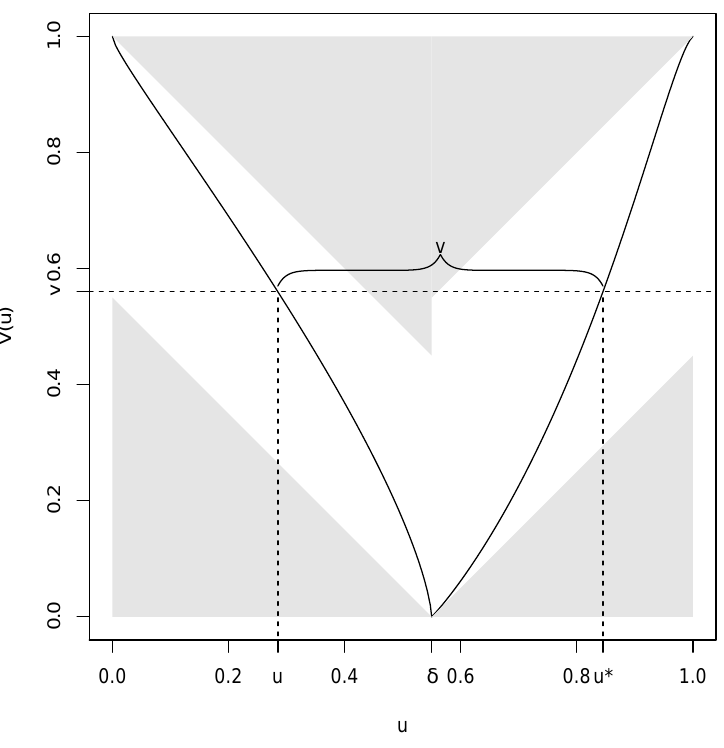
Figure 3. An asymmetric v-transform from the family defined in (7). For any v-transform, if v = V ( u ) and u ∗ is the dual of u , then the points ( u ,0 ) , ( u , v ) , ( u ∗ ,0 ) and ( u ∗ , v ) form the vertices of a square. For the given fulcrum δ , a v-transform can never enter the gray shaded area of the